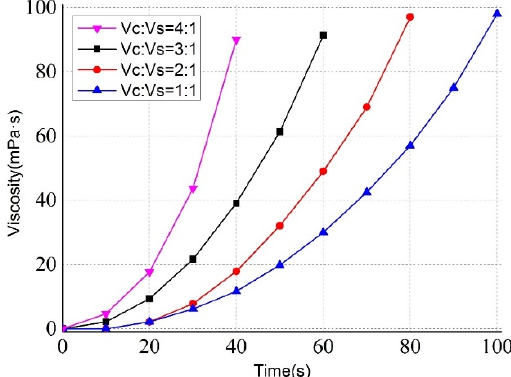
Figure 2. Curves of viscosity change with time for different mixture ratios of cement–sodium silicate (C-S) grout.